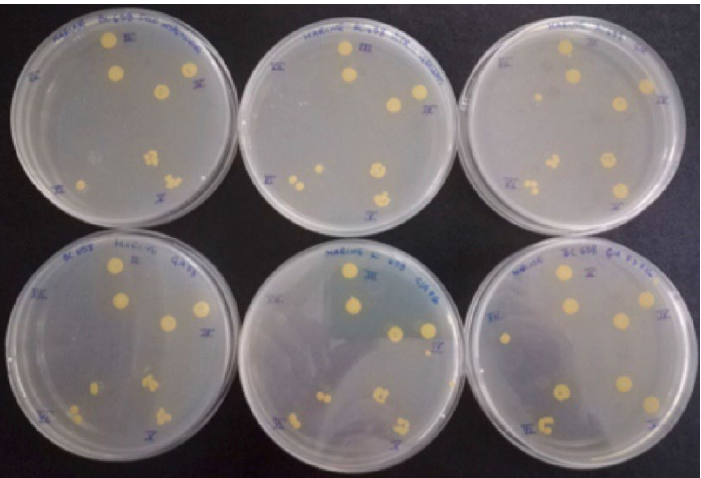
Figure 19. Petri dishes containing marine agar inoculated with the spot technique. Separate colonies were counted only at the higher dilutions.